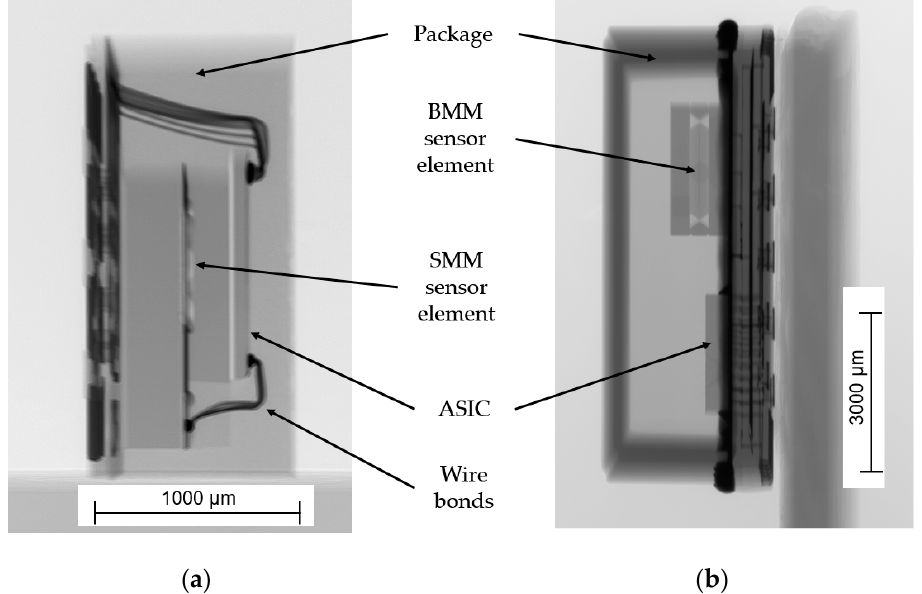
Figure 2. X-ray images of silicon MEMS acceleration sensors (not to scale). Images were made with a Nikon HMXST 160 computed tomography scan (CT): ( a ) Bosch BMA 280 with a three-axis SMM sensor element and a package size of 2 × 2 × 0.95 mm 3 ; ( b ) Safran Colibrys SI1003.A with a one-axis BMM sensor element in an LCC20 package with a size of 9 × 9 × 3.3 mm 3